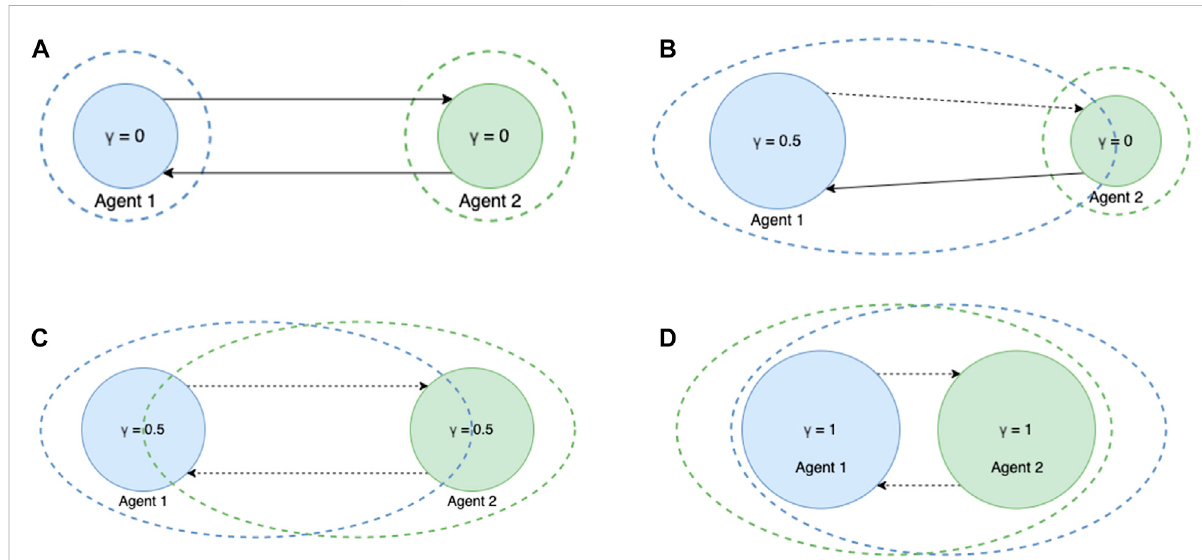
FIGURE 1 Demonstrating interaction between agents of different transcendence levels (A) Non-transcended vs . Non-transcended interaction (B) Partially-transcended vs . Non-transcended interaction (C) Partially-transcended vs . Partially-transcended interaction (D) Fully-transcended vs . Fully-transcended